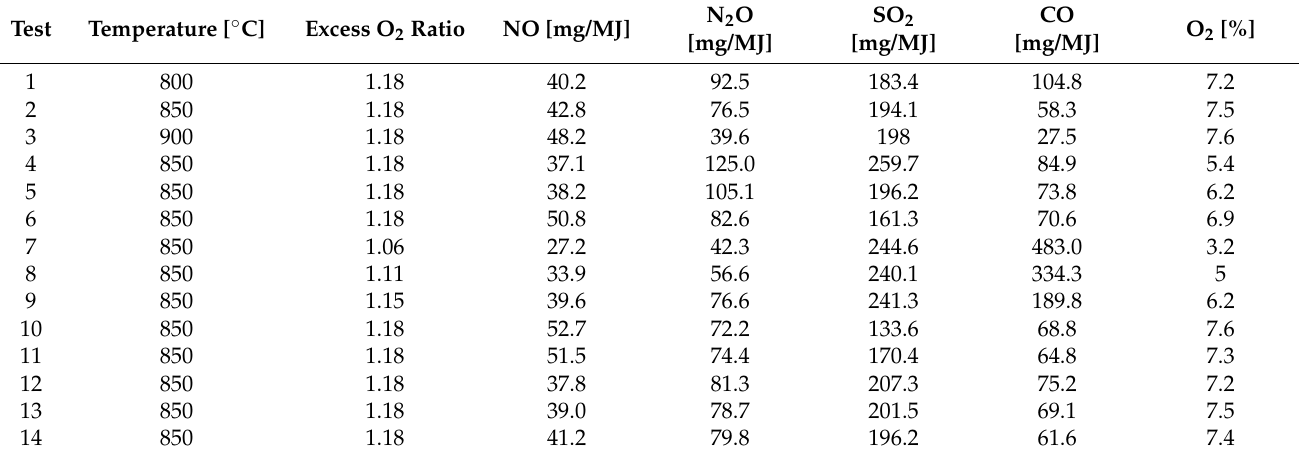
Table 6. Experimental condition and results in the tests by Li [42].